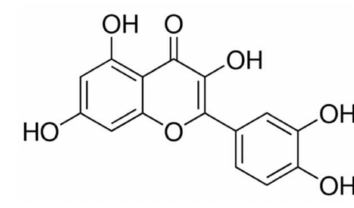
Figure 1. Chemical structure of